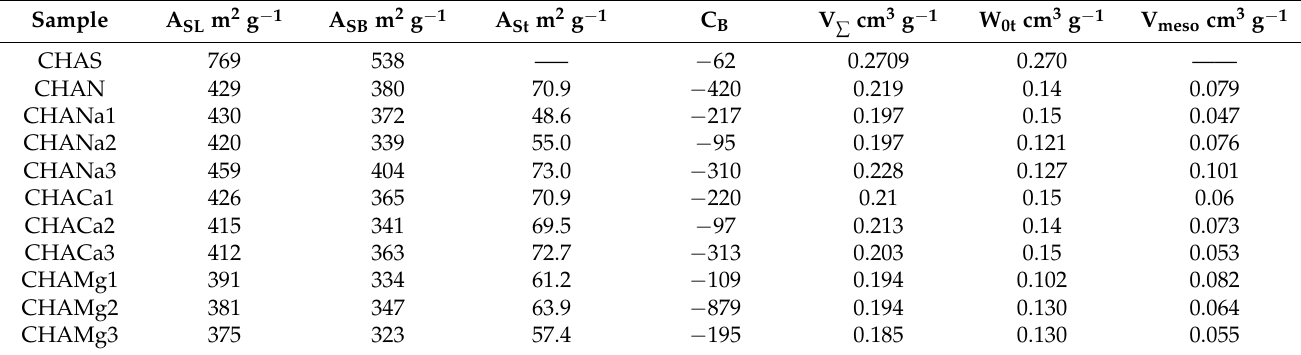
Figure 4. ( A ) N 2 adsorption isotherms at 77 K in CHA zeolites. ( B ) N 2 adsorption isotherms at 77 K in CHA zeolites, logarithmic scale. Table 4. Textural parameters of natural and exchanged chabazite, adsorption of N 2 at 77 K. Sample